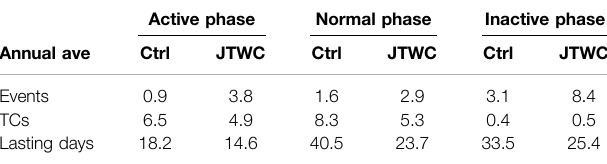
TABLE 4 | Statistics of all events of the three MTC phases (observed data are the JTWC data for 1991 – 2012). Active